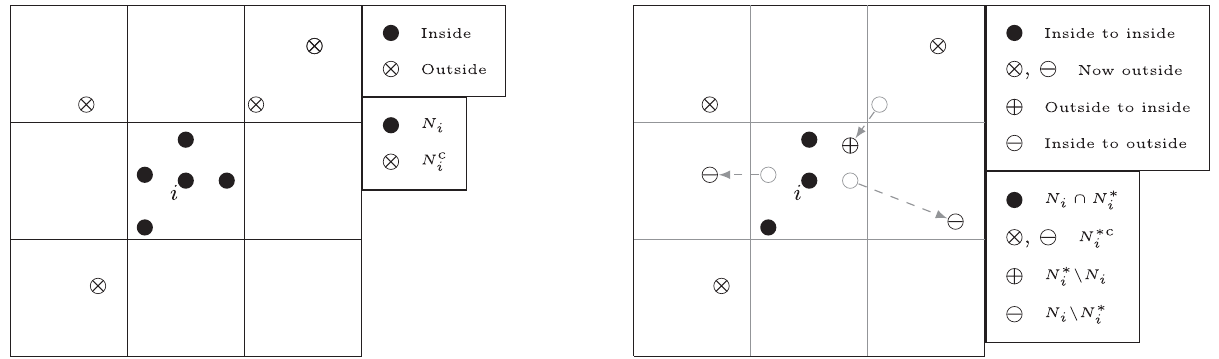
FIG. 3. Field contributions of outside particles (left) are now due to field contributions of particles now outside minus inside to outside particles plus outside to inside particles (right). Particles that were in N